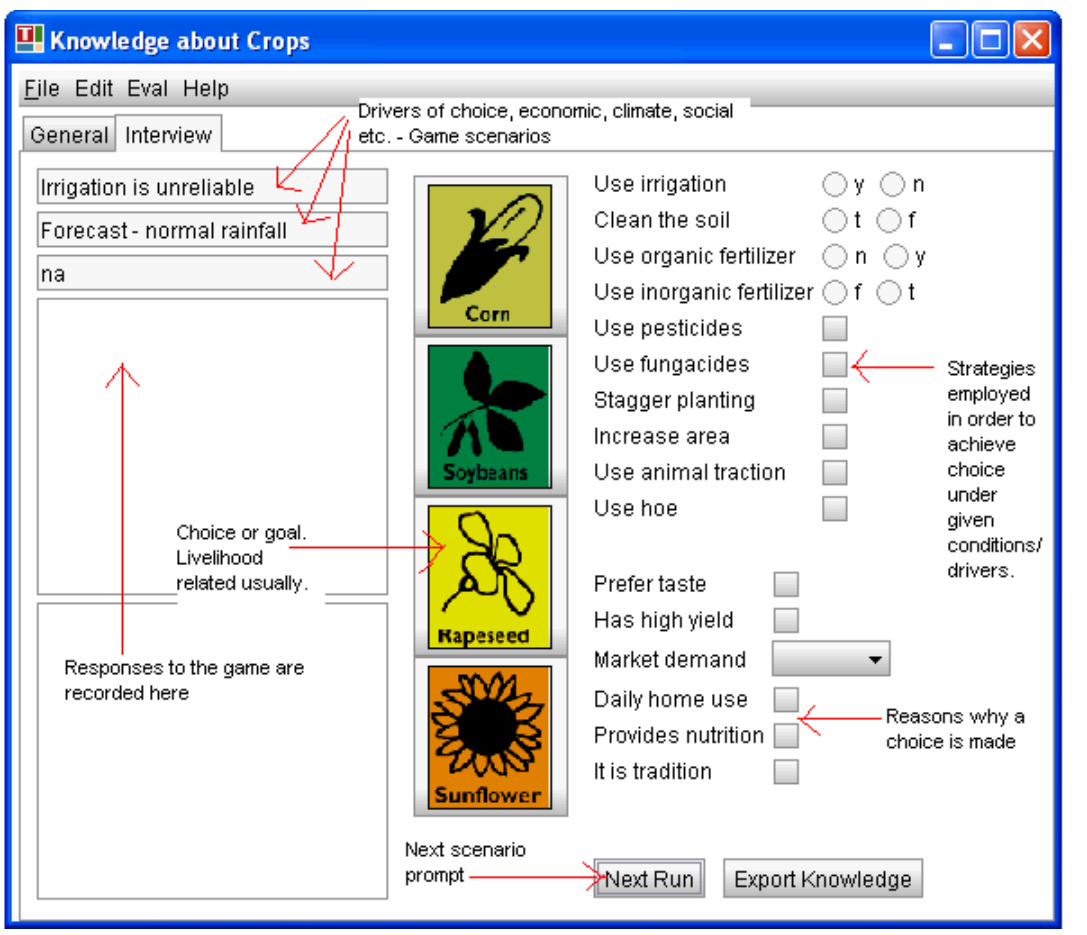
Fig. 2 . KnETs interactive